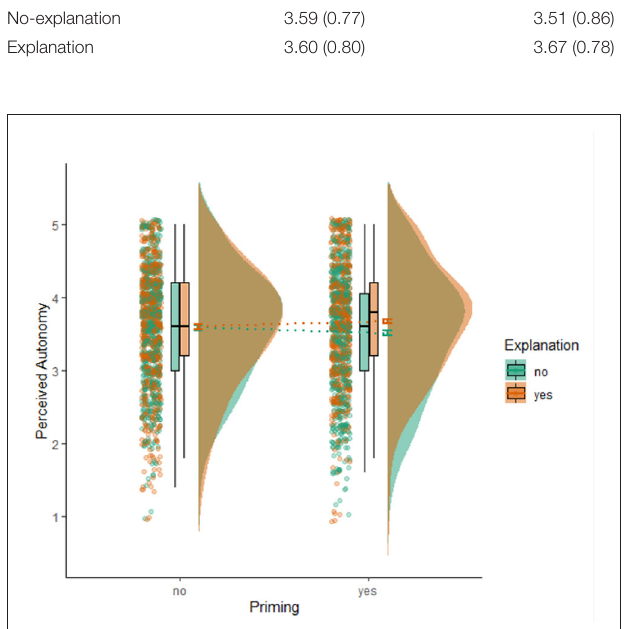
FIGURE 2 | Visualization of means, standard errors, boxplots, distributions, and raw data points of perceived autonomy for the four experimental conditions.